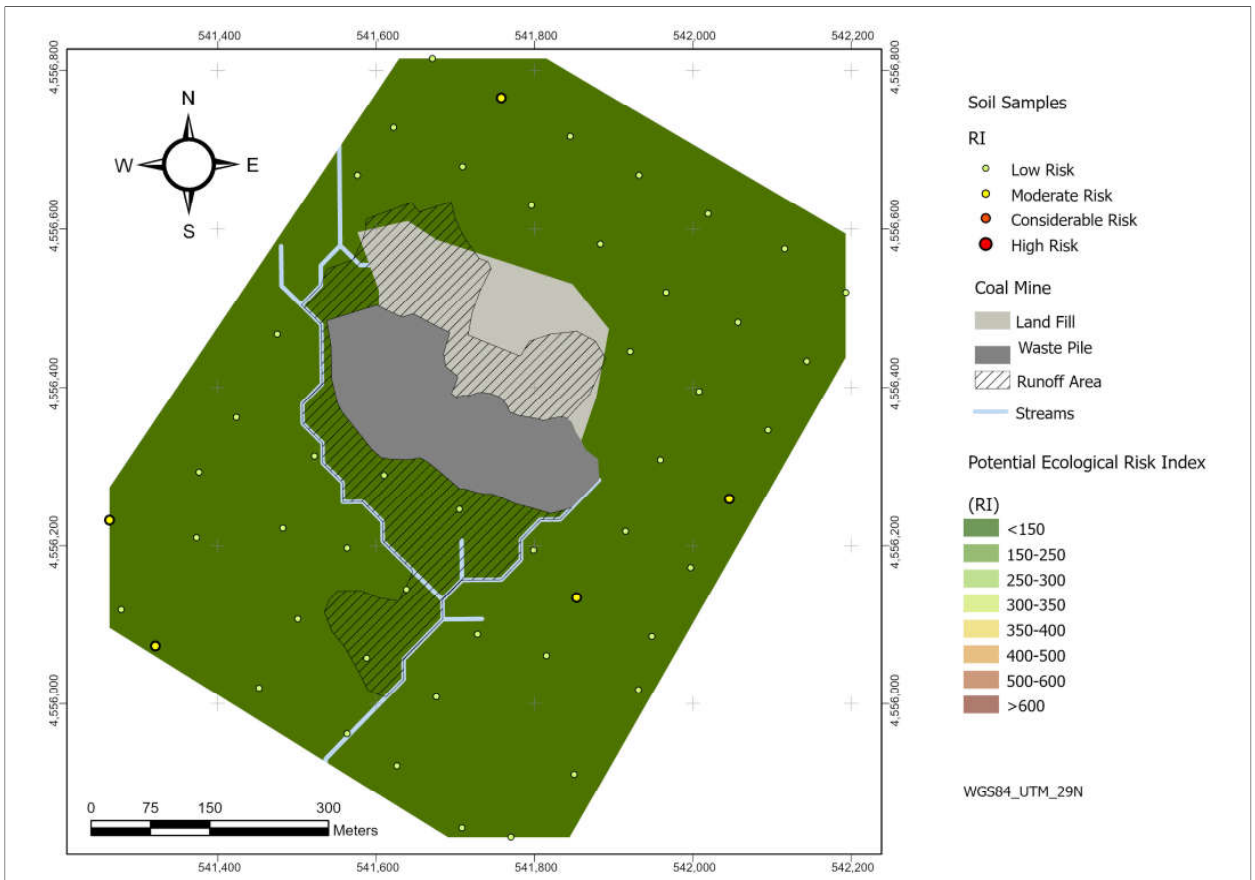
Figure 6. Potential ecological risk index determined using regional background as the geochemical baseline.